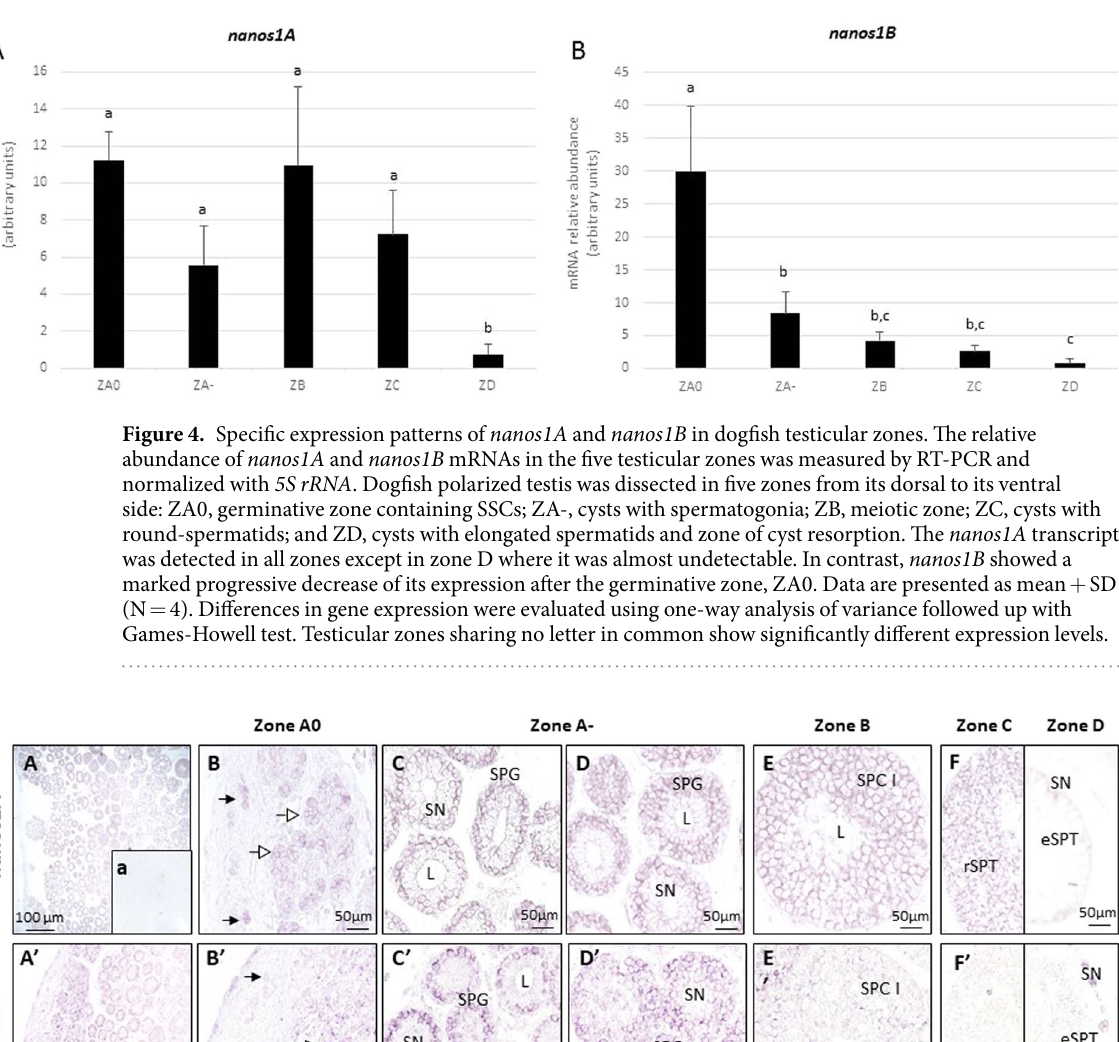
types: granulosa cells adjacent to zona pellucida and theca cells outside the basal lamina. Theca is vascularised and consists in fibroblastic-like inner cells and cuboidal outer cells. In vitellogenic follicles, nanos1 transcripts were detected in both granulosa and theca cells (Fig. 7C,C’) whereas undifferentiated follicular cells previously showed no signal in primordial follicles (Fig. 7A,A’). In larger vitellogenic follicles which have multilayed granulosa cells, nanos transcripts were still present in both granulosa and theca cells (Fig. 7D,D’). As expected, sense riboprobes gave no signal (Fig. 7E,E’). So, nanos1A and nanos1B transcripts were both first detected in primary oocytes before vitellogenesis and later, in granulosa and theca cells surrounding vitellogenic oocytes.